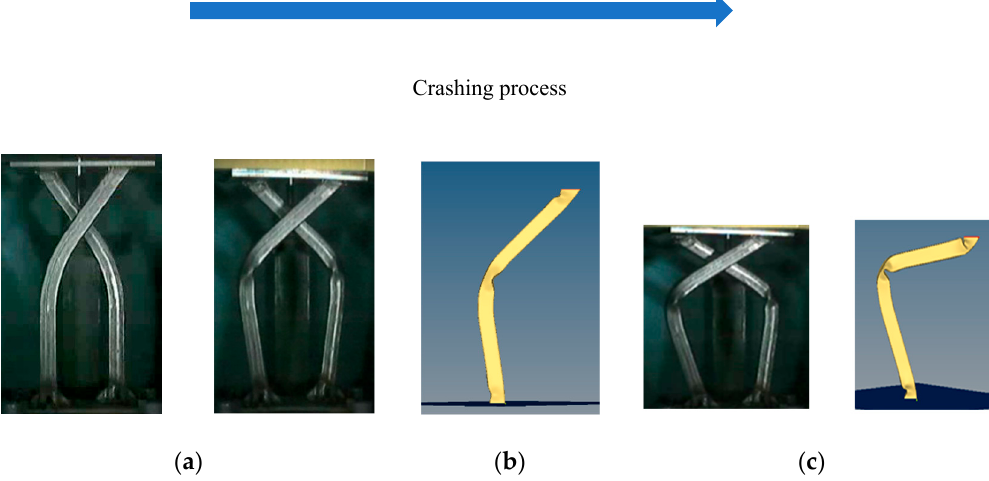
Figure 12. Comparison of crash deformation of overall-quenched product between experiment and simulation in axial crash test: ( a ) initial product shape, ( b ) axial stroke = 15 mm, ( c ) axial stroke = 150 mm.